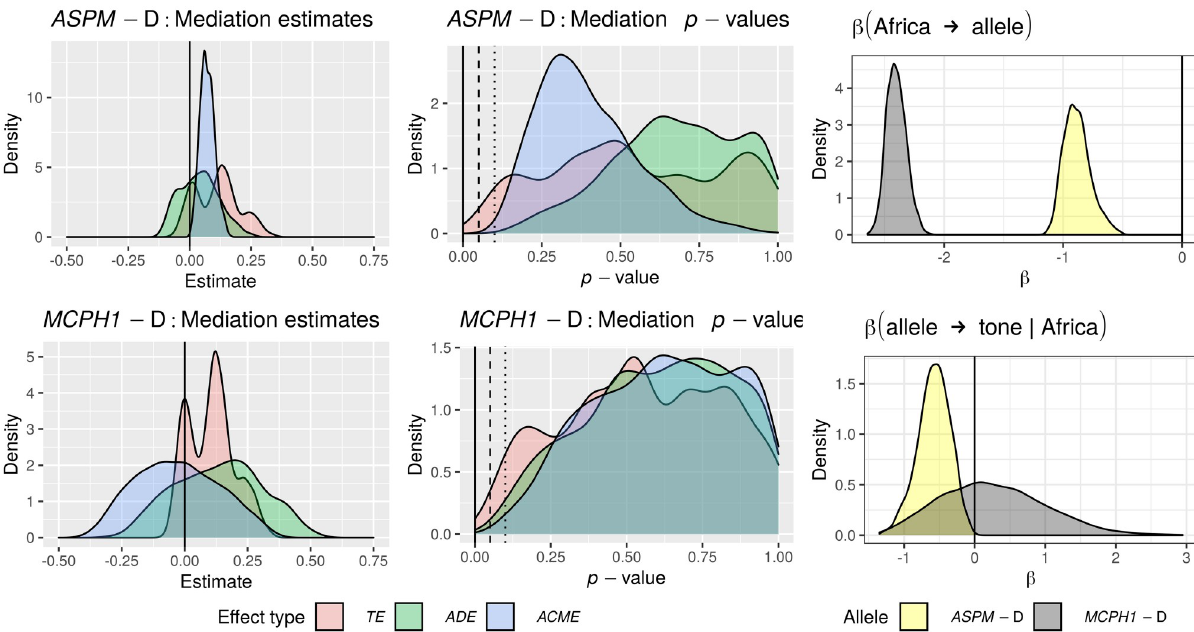
Fig 20. Mediation analysis for 1,000 restricted samples for tone2 . Same conventions as in Fig 11. See Table 11 for the numeric summaries.